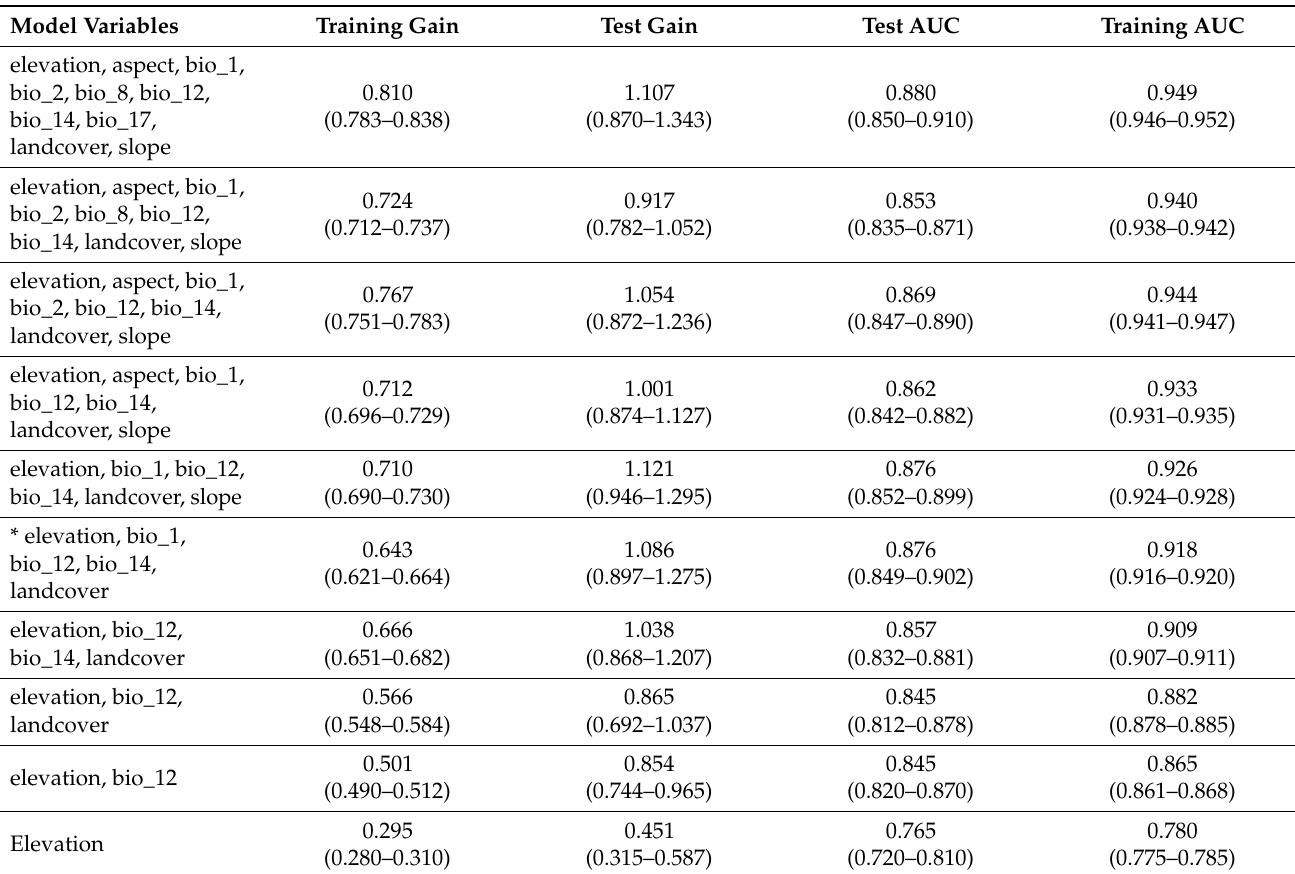
Table 2. MaxEnt general and reduced models for the cheer pheasant using bioclimatic, topographic and land cover